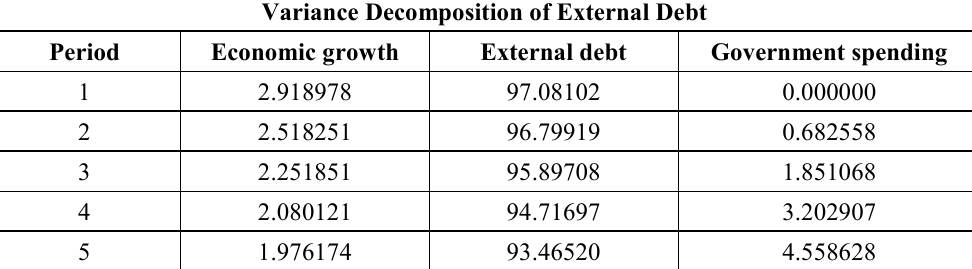
Table 12. Variance Decomposition of External Debt Results